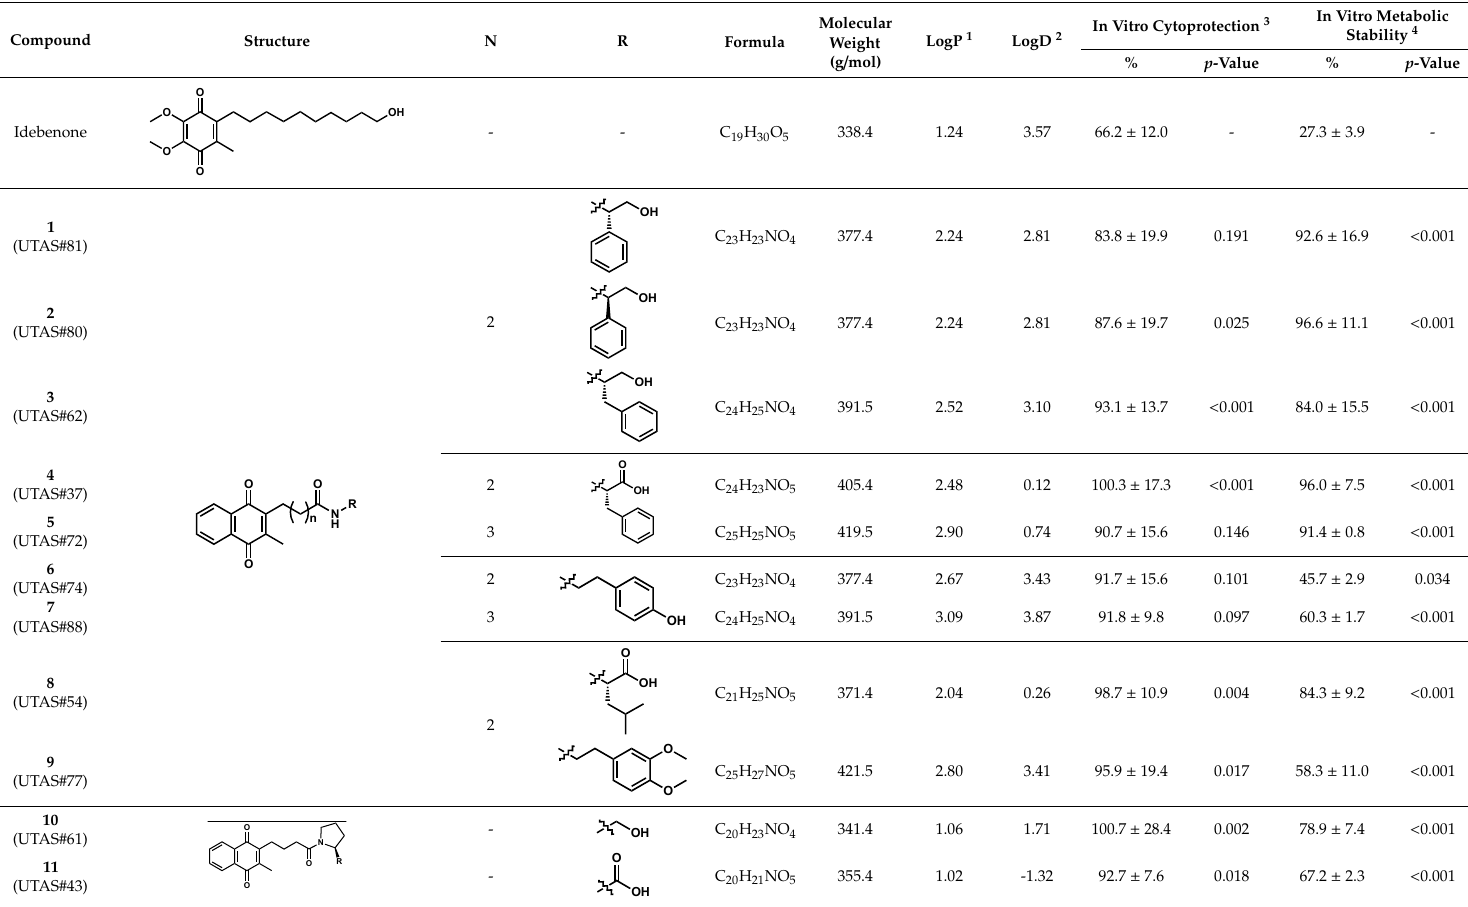
Table 1. Chemical structure, physical properties, in vitro efficacy, and stability of the benzoquinone idebenone and 11 novel naphthoquinone derivatives.